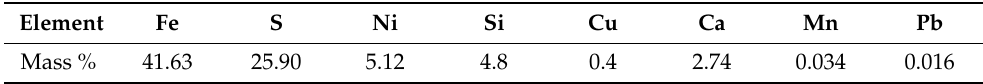
Table 1. Chemical composition of the initial pentlandite